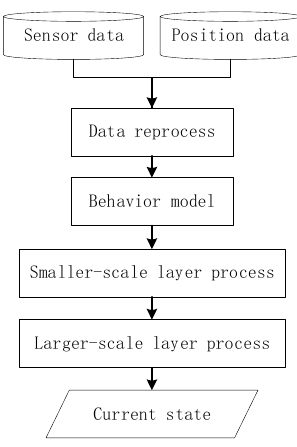
Figure 2. Overall flowchart of proposed method.